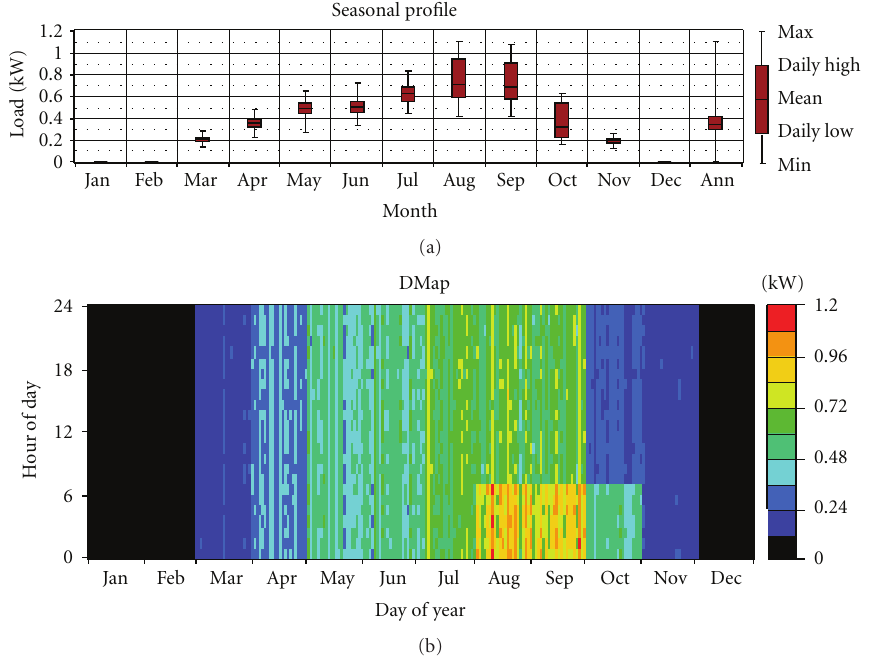
Figure 2: Profile of average daily demand for water heating and space